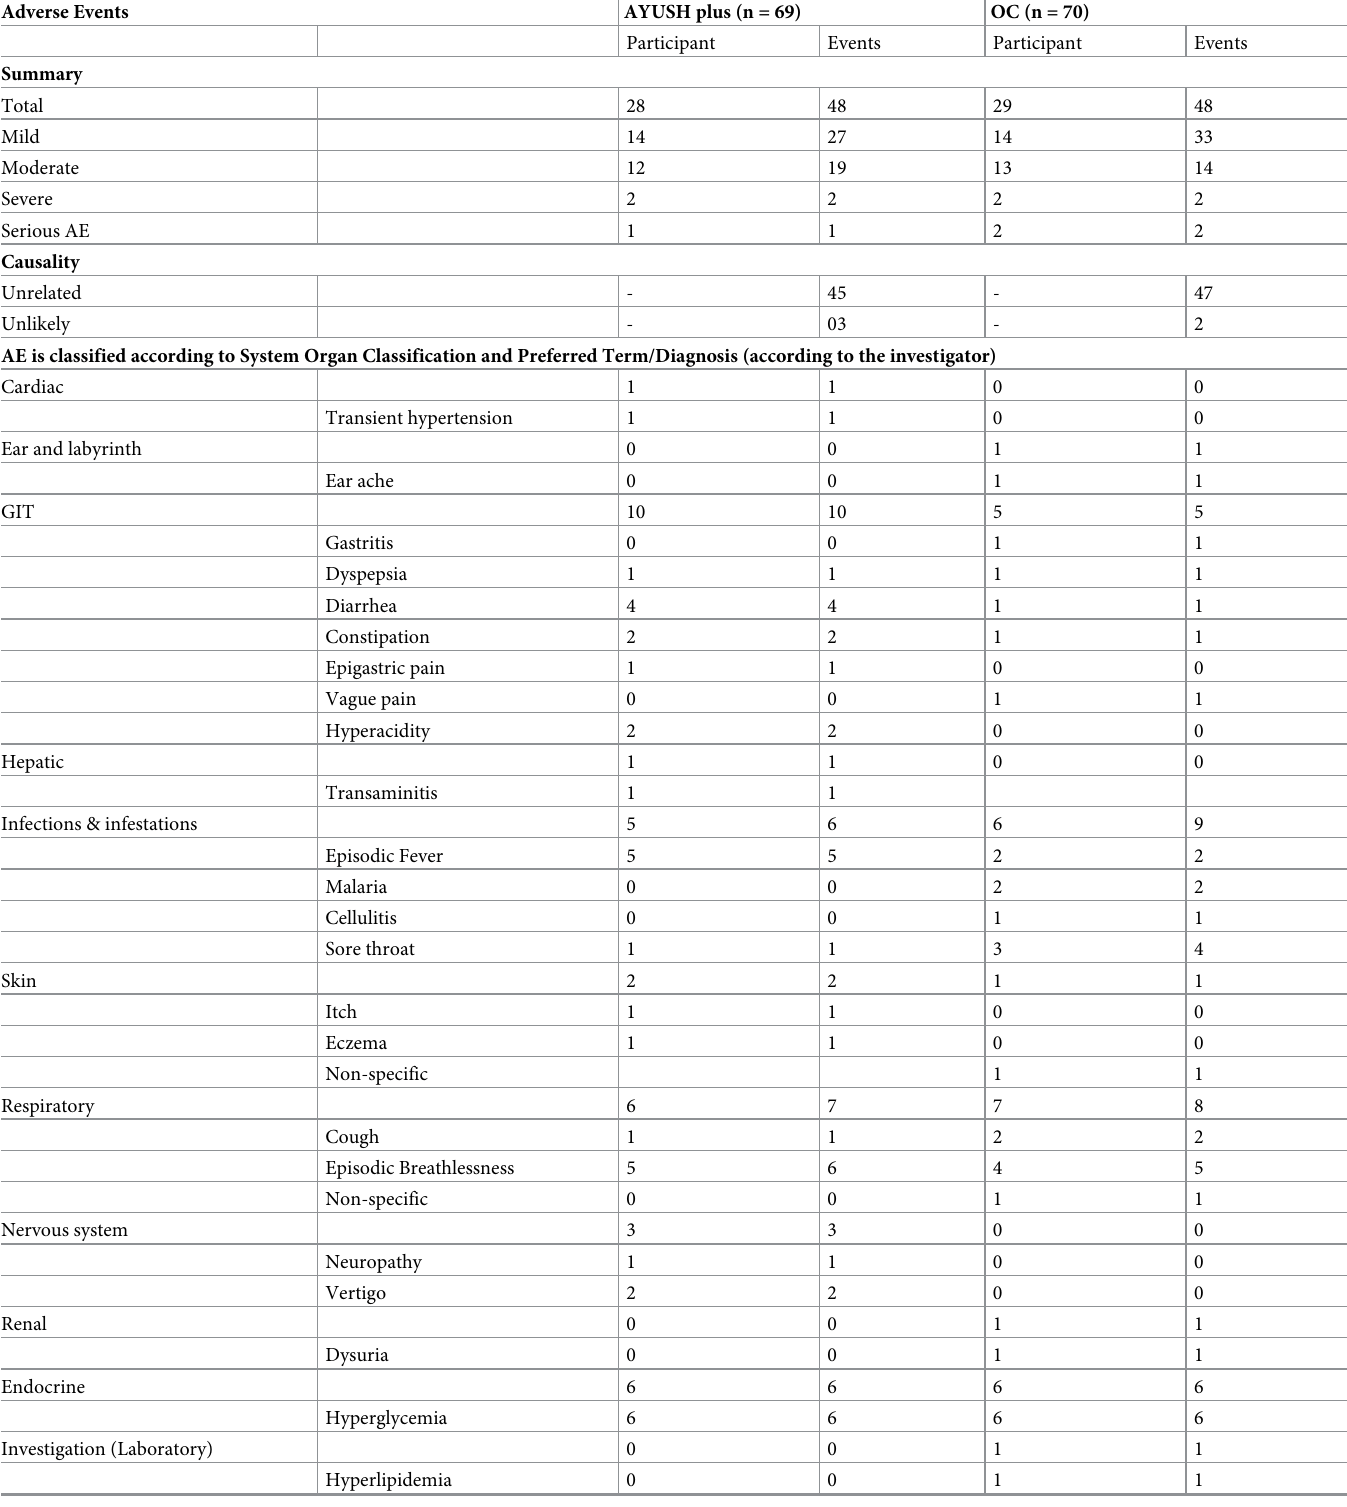
Table 5. Adverse events (AE) in the two study groups � (n =